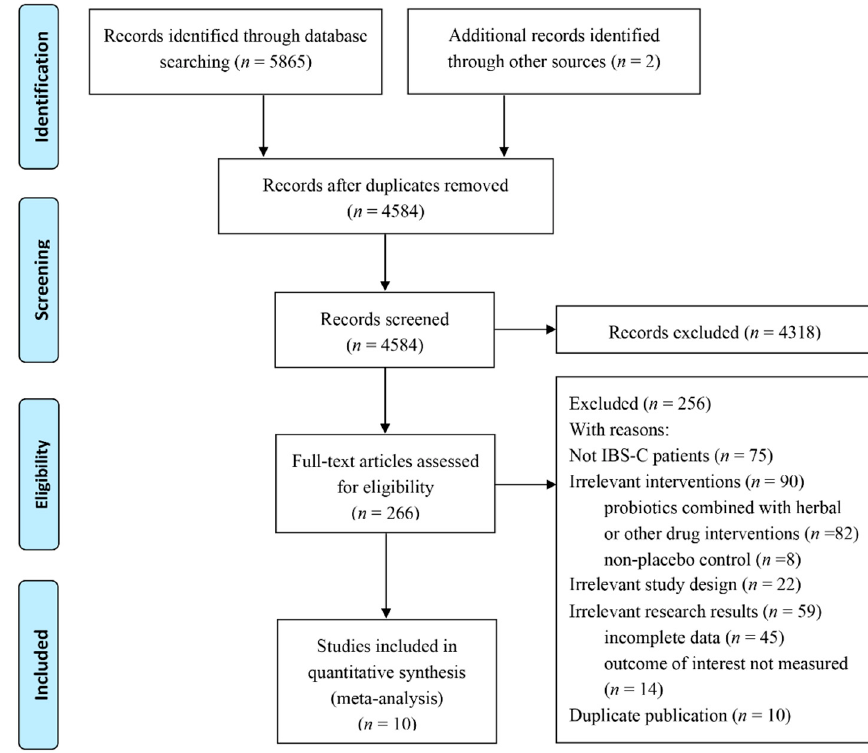
Figure 1. Flow diagram of the literature screening process and results.